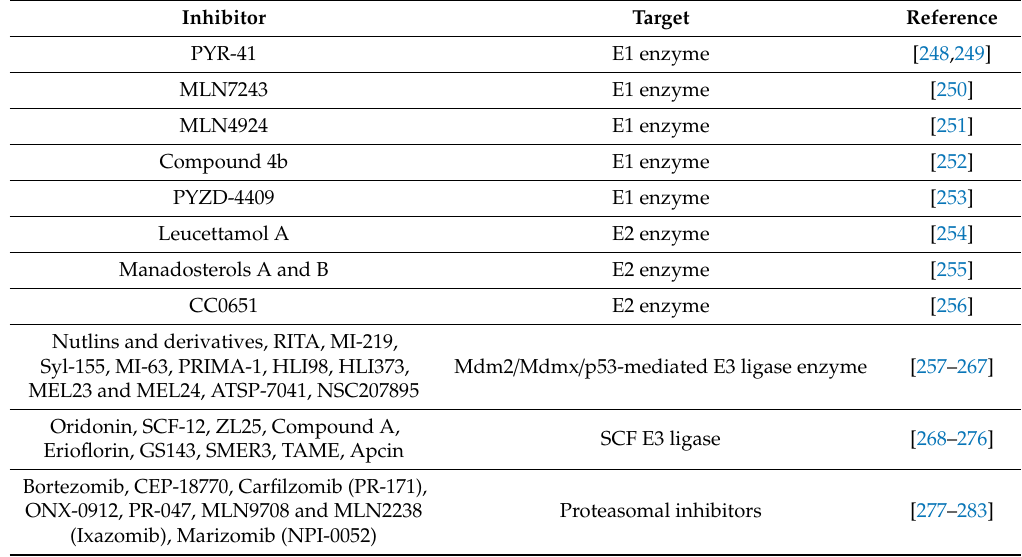
Table 2. Inhibitors of the